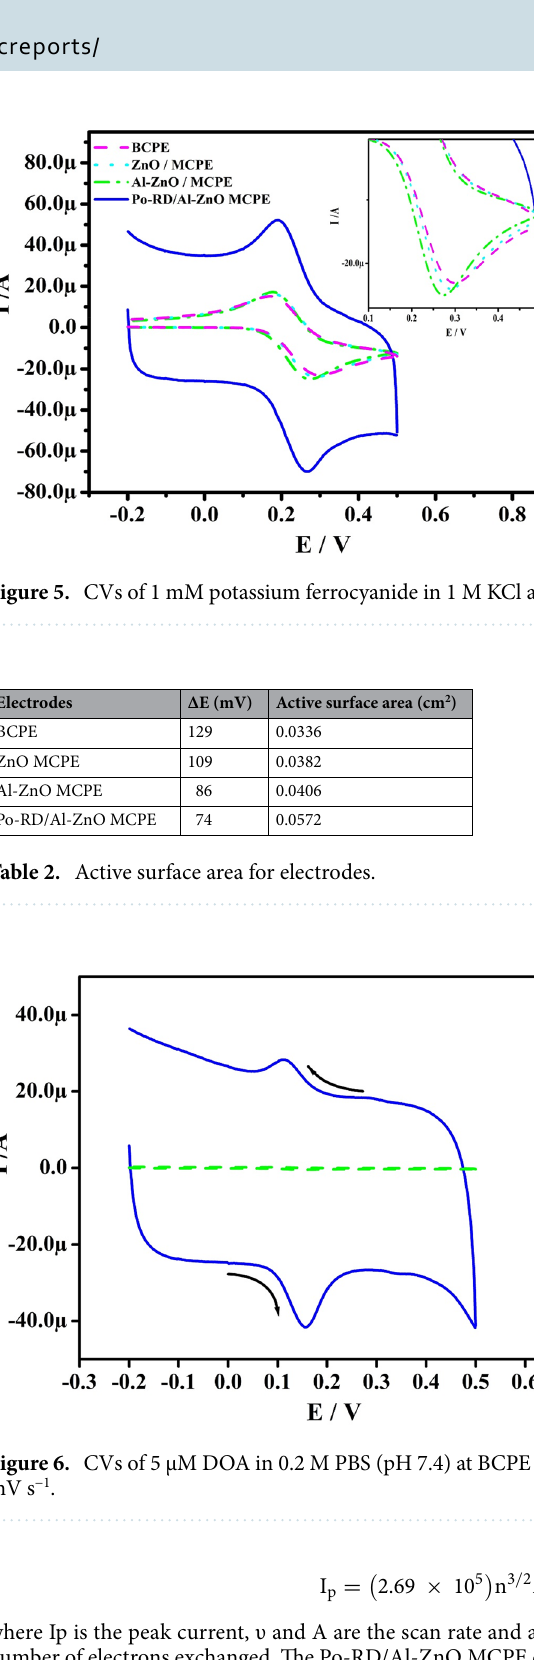
Figure 6 exhibits a CV profile of 5 μM DOA at BCPE & Po-RD/Al-ZnO MCPE in 0.2 M phosphate buffer solution (PBS) (pH 7.4). The Po-RD/Al-ZnO